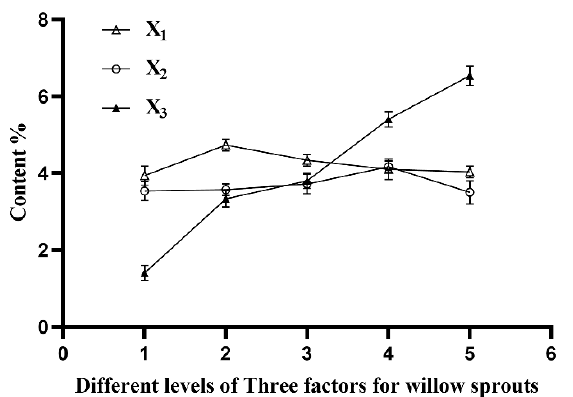
Figure 1. Effects of ethanol concentration (X 1 , %), extraction time (X 2 , min), and ratio of solvent to material (X 3 , mL/g) on the extraction efficiency of TFW.